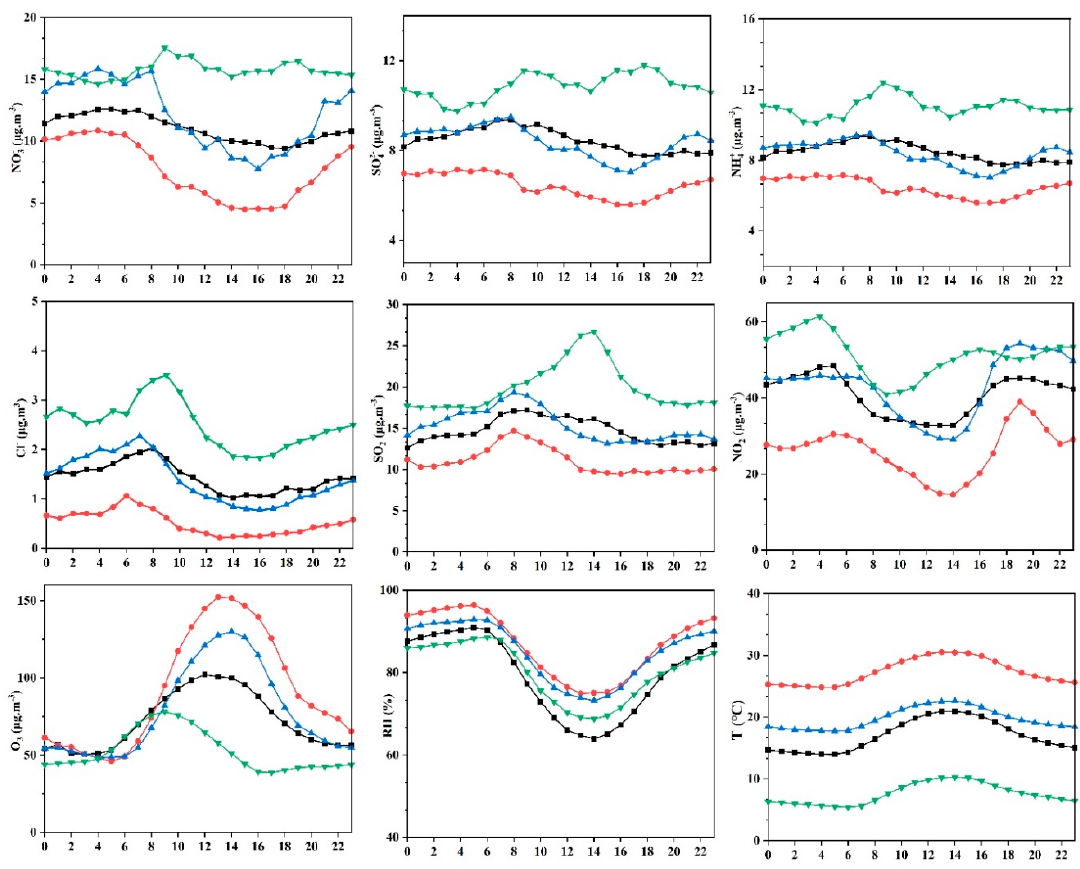
Figure 3. Diurnal variations of chemical species in PM 2.5 , gaseous pollutants and temperature, RH (Relative Humidity) in four seasons. Notes: black—spring, red—summer, blue—autumn, green— winter.